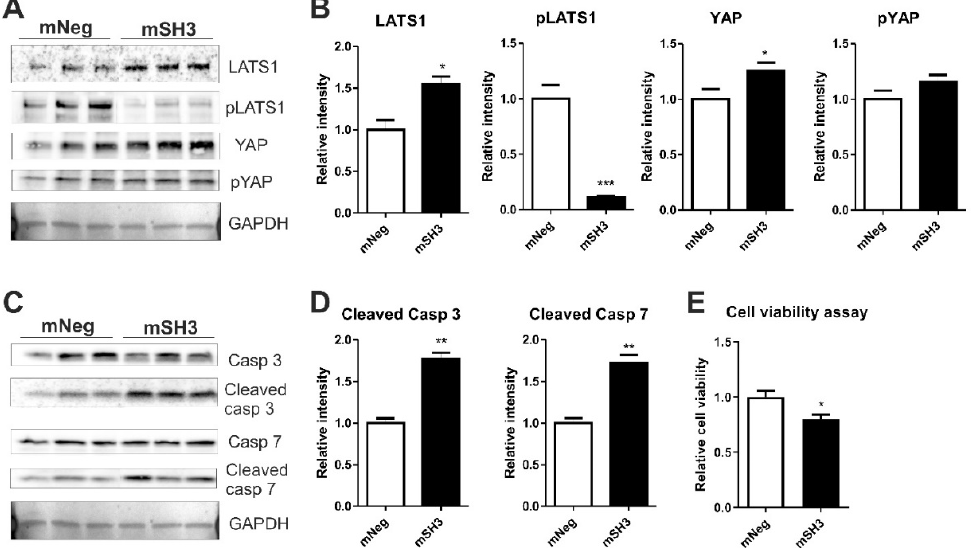
Figure 4. Knockdown of SH3BGR affects cell viability and augments apoptosis via hippo signaling- ( A ) SH3BGR knockdown dramatically reduced the phosphorylation of LATS1 and moderately increased total YAP without altering